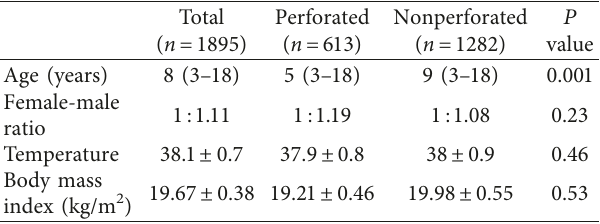
Table 1: Demographic characteristics of children with acute